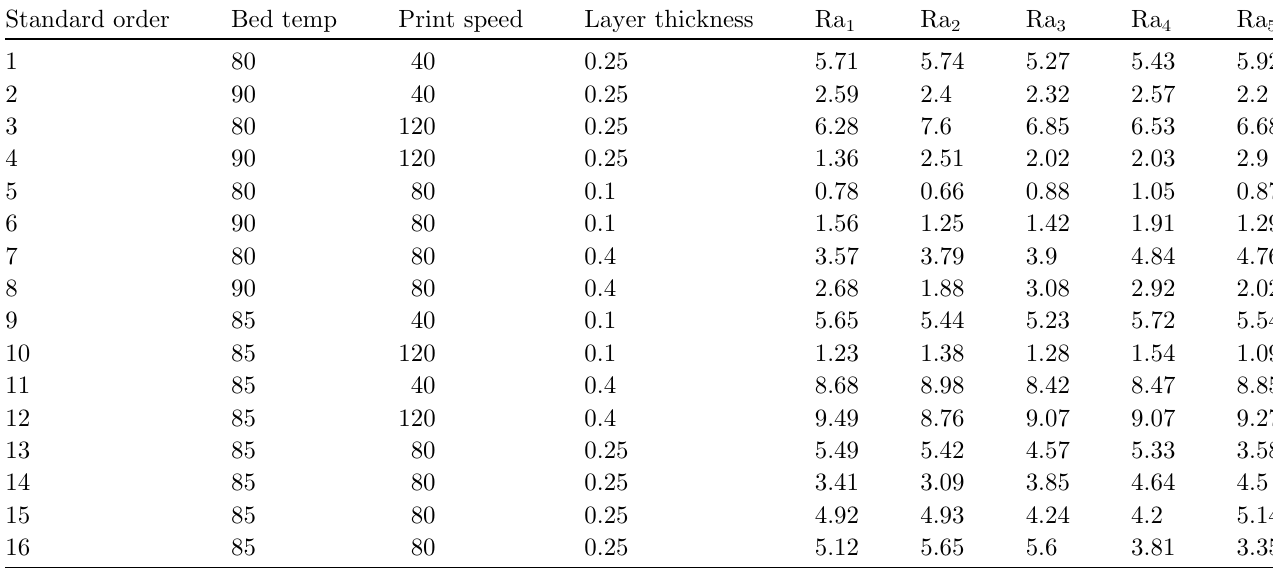
Table 2. Design matrix of top surface roughness. Standard order